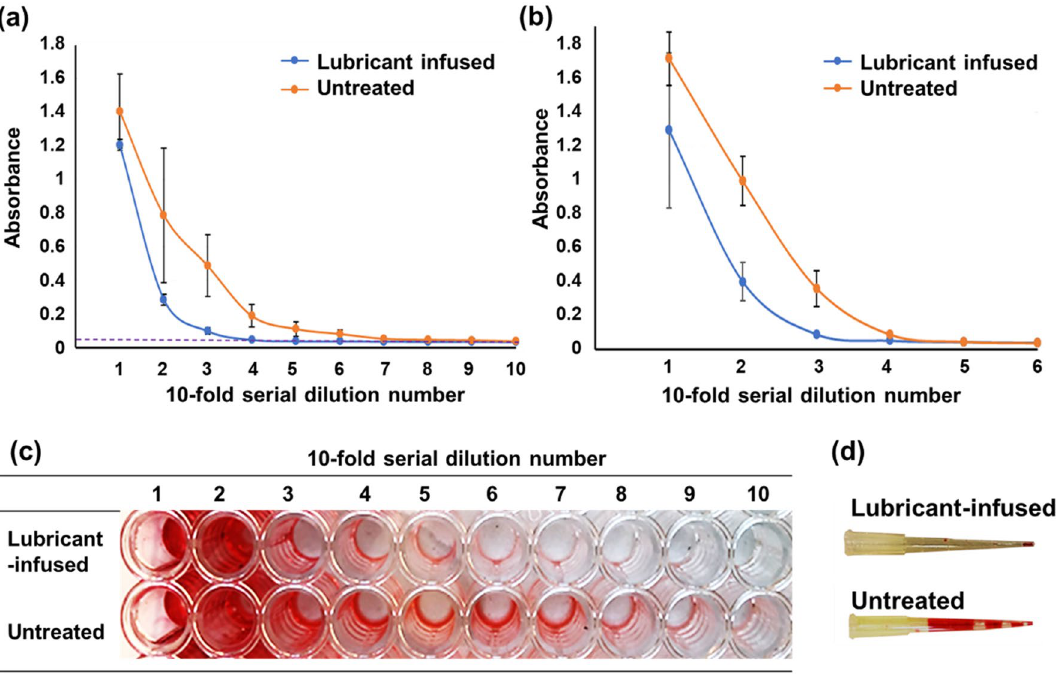
Figure 4. Absorbance of the red dye at different concentration after performing tenfold serial dilutions using ( a ) 10 μL and ( b ) 200 μL untreated tips compared to fluorosilanized lubricant infused tips. For each experiment a single tip was used for all the serial dilutions. Dashed line in ( a ) represents the absorbance at zero concentration of the red dye. The results are presented as means ± S.D. ( c ) Serial dilutions of the red dye in a well plate using single 10 μL untreated and lubricant infused tips. Untreated wells showed higher residue carryover of dye, as dilution did not occur effectively. ( d ) Comparison of the red dye attachment to 200 μL untreated tips and fluorosilanized lubricant infused